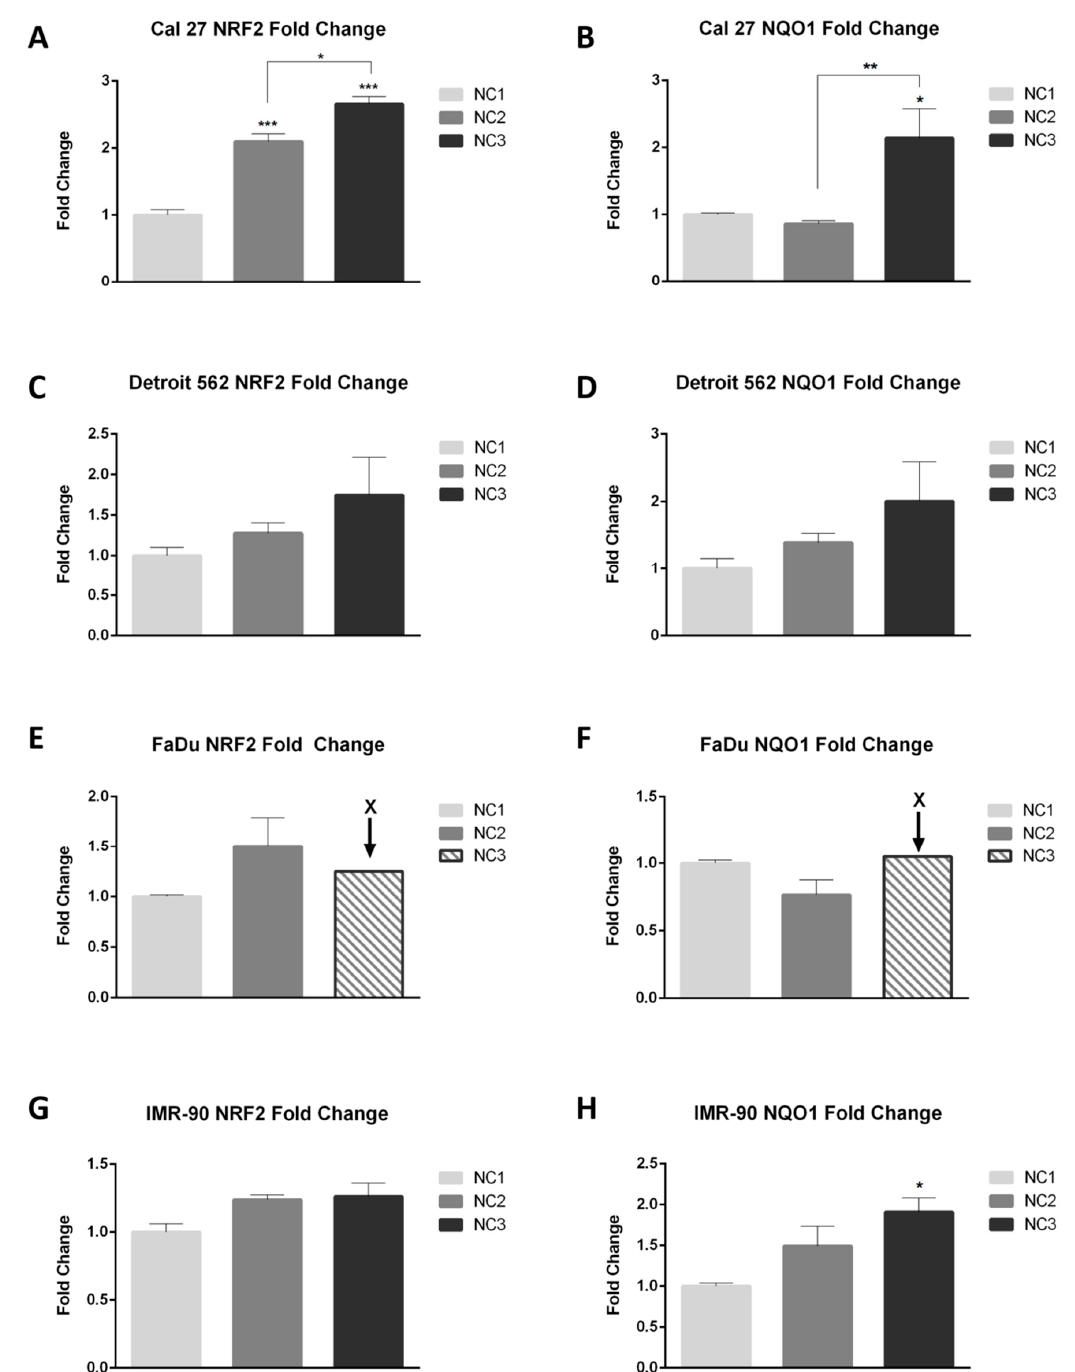
Figure 3. The quantification of target transcripts, NRF 2 and NQO 1, in real time (RT-qPCR). One-way ANOVA with Tukey post hoc test was used to test the differences with respect to the quantity of NRF 2 and NQO 1 mRNA, under different nutritional conditions. The values are shown as the mean ± SD. n = 3. * p < 0.05; ** p < 0.01; *** p < 0.001; **** p < 0.0001. * The Fold Change for NRF2 and NQO1 in FaDu under NC3 was estimated according to the Ct values.